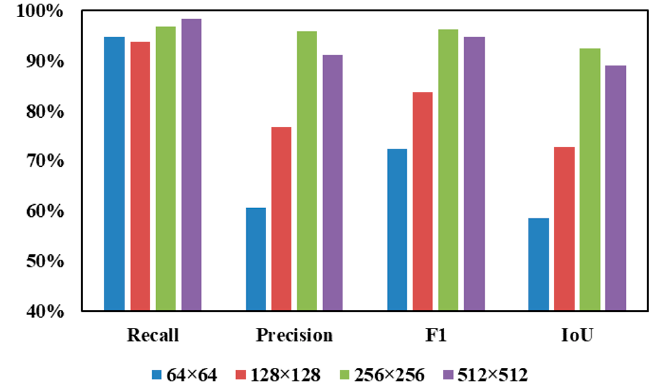
Figure 4. Four evaluation metrics results obtained for four patch sizes.